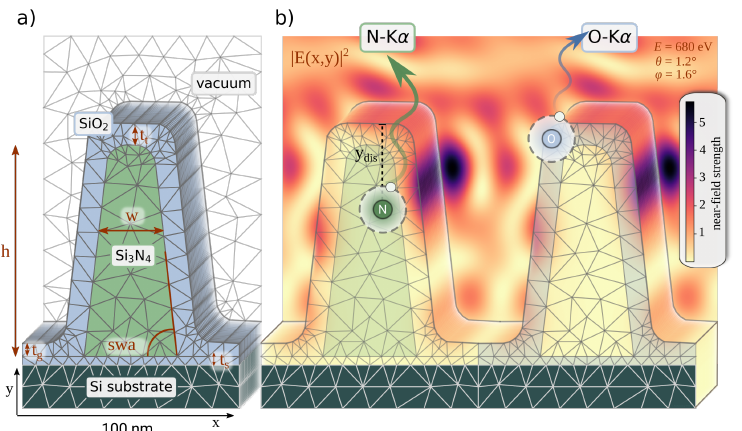
Figure 1. ( a ) Cross-section with the finite-element mesh grid showing the layout used for the simulation. The height h , the width w , the sidewall angle swa , and the oxide layer thicknesses in the groove t g and on the grating line t t were optimized as independent parameters. The oxide layer on the substrate t s was kept constant during the optimization. ( b ) The calculated electric field strength inside and outside the structure is shown for θ = 1.2 ◦ and ϕ = 1.6 ◦ . For the nitrogen and oxygen fluorescence, the electric field strength is integrated and the reabsorption is calculated with the distance y dis the photon has to travel to leave the